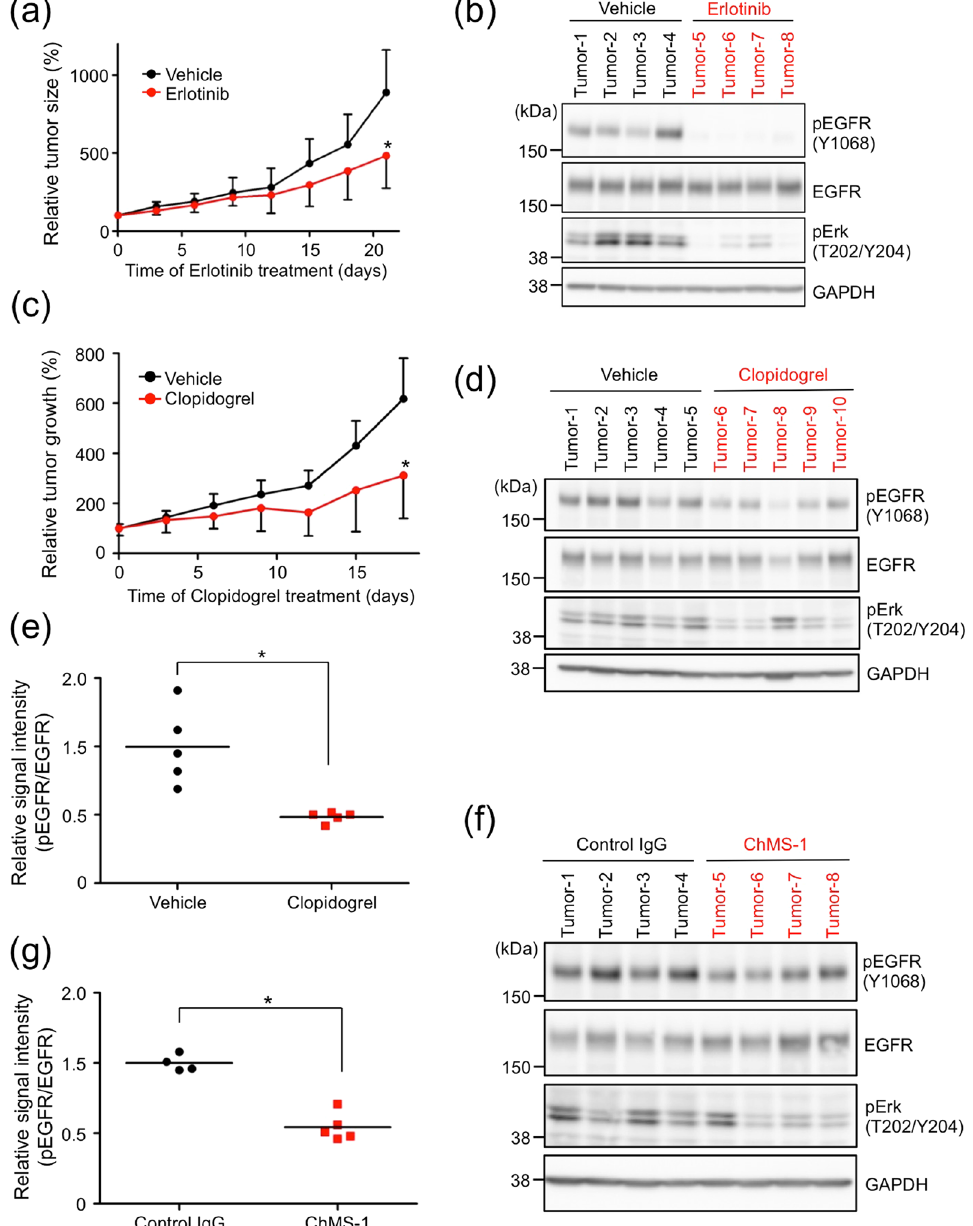
Figure 5. Activation of EGFR signalling induced by PMPA was suppressed by treatment of antiplatelet agent or podoplanin-neutralizing antibody in vivo . ( a , b ) PC-10 cells (5 × 10 6 cells) were subcutaneously injected in BALB/ c-nu/nu mice. After 15 days, BALB/c-nu/nu mice bearing PC-10 tumour were dosed orally with 50 mg/kg erlotinib daily. Tumour volume was measured every 3 days ( a ). All data are shown as means ± SD. (N = 4) * P < 0.05 by Mann–Whitney U -test. After 3 weeks, the tumours were extracted and homogenized in SDS lysis buffer. The phosphorylated-EGFR signal in the tumours was analysed by Western blot ( b ). Multiple exposure images of full-length blots were presented in Supplementary Fig. S8. ( c – e ) PC-10 cells (5 × 10 6 cells) were subcutaneously injected in BALB/c-nu/nu mice. After 15 days, clopidogrel dissolved in drinking water with 0.003% HCl (equal to orally dosed 25 mg/kg/daily) was given to BALB/c-nu/nu mice bearing PC-10 tumours. Tumour volume was measured every 3 days ( c ). All data are shown as means ± SD. (N = 5) * P < 0.05 by Mann–Whitney U -test. After 18 days, the tumours were extracted and homogenized in SDS lysis buffer. The phosphorylation of EGFR signal in the tumours was analysed by Western blot ( d ) and the signal intensity of EGFR phosphorylation was quantified by Image J software (NIH) ( e ). * P < 0.05 by Mann–Whitney U -test ( f , g ). PC-10 cells (5 × 10 6 cells) were subcutaneously injected into NOD/SCID mice. After 18 days, these mice were treated with 100 μ g/mouse control human IgG or chimeric MS-1 (ChMS-1) antibody every week by intravenous administration as previously described 5 . After 15 days, the tumours were extracted and homogenized in SDS lysis buffer. The phosphorylated- EGFR signal in the tumours was analysed by Western blot ( f ), and the signal intensity of EGFR phosphorylation was quantified by Image J software (NIH) ( g ). (N = 4) * P < 0.05 by Mann–Whitney U